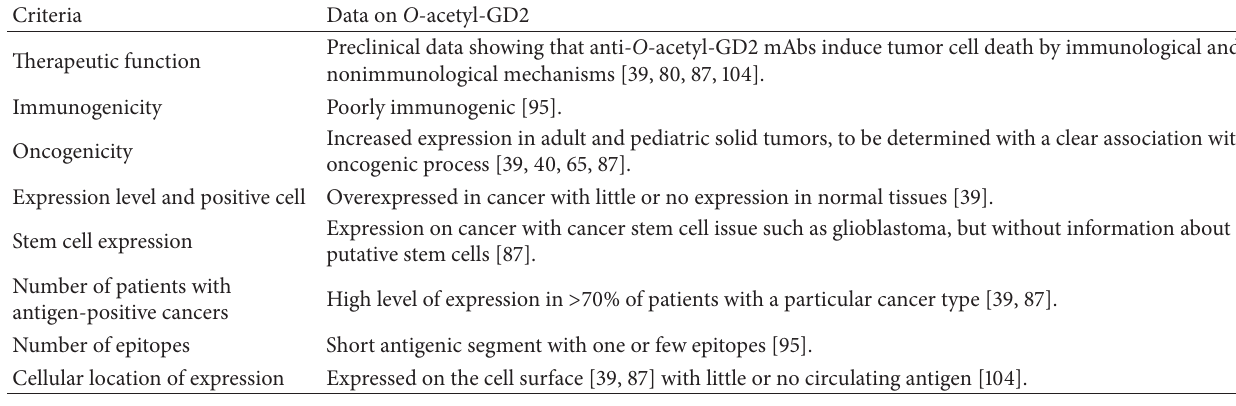
Table 1: Relevant characteristic of O -acetyl-GD2 ganglioside as a cancer antigen according to Cheever et al. [26].